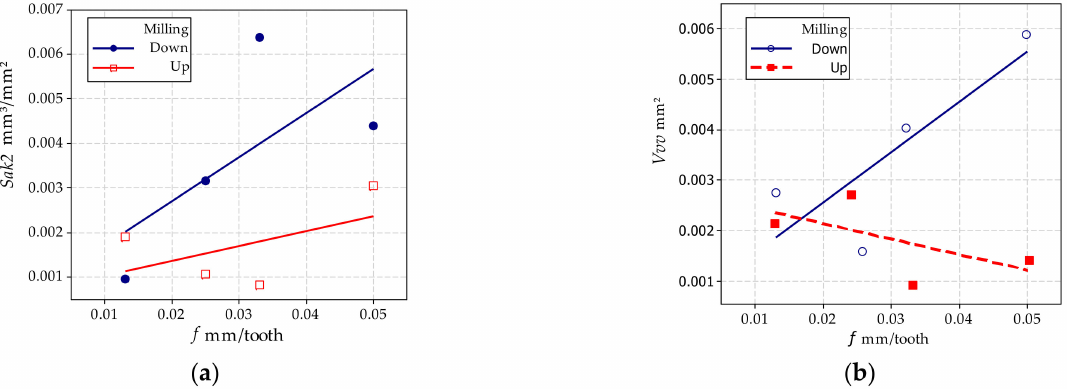
Figure 9. Graphical representation of the effect of feed rate and milling type on the parameters Sak2 ( a ) and Vvv ( b ).